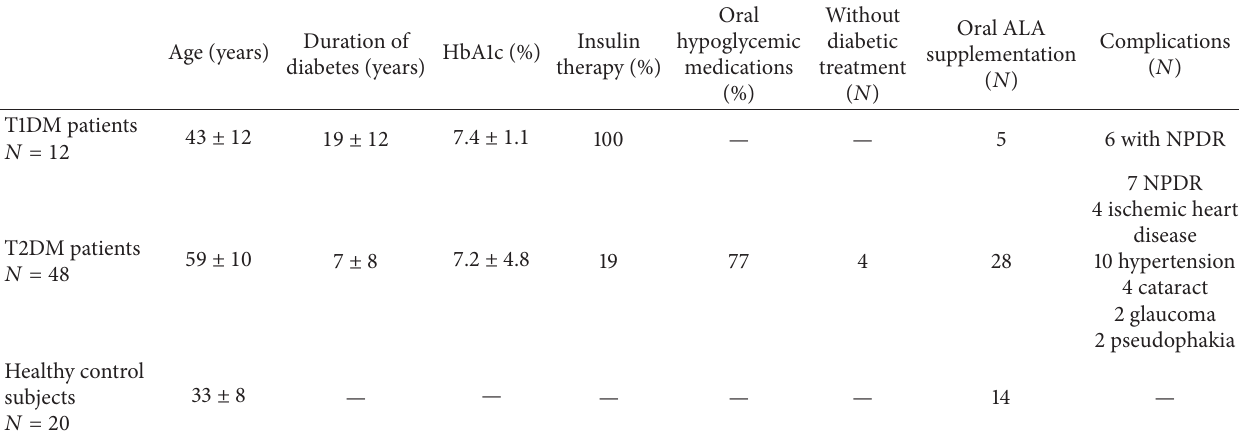
Table 1: Clinical characteristics of patients with T1DM, T2DM, and healthy control